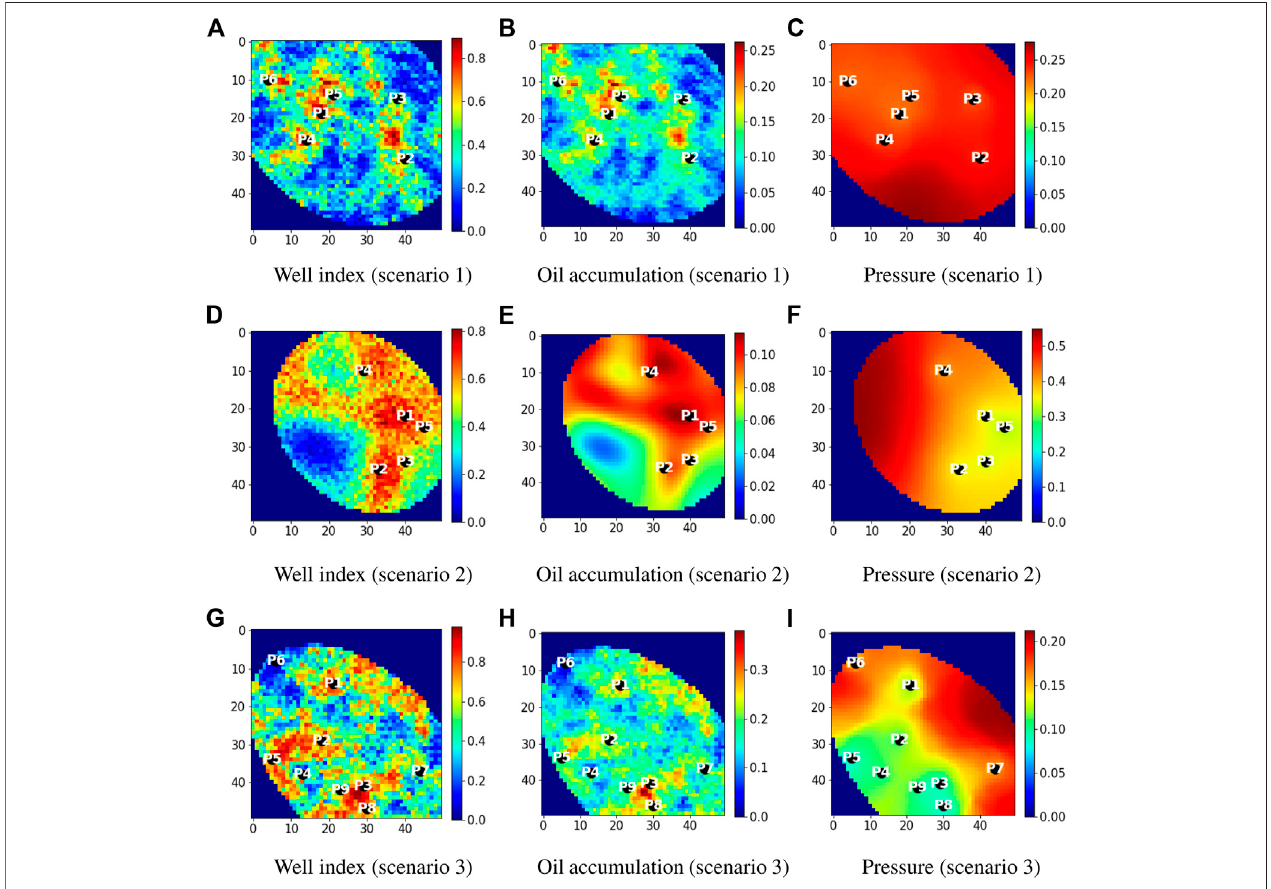
FIGURE 9 | Well con fi guration proposed by the best arti fi cial intelligence agent for three random 2D fi eld development scenarios. The well numbers indicate the drilling stage in which the wells are drilled.